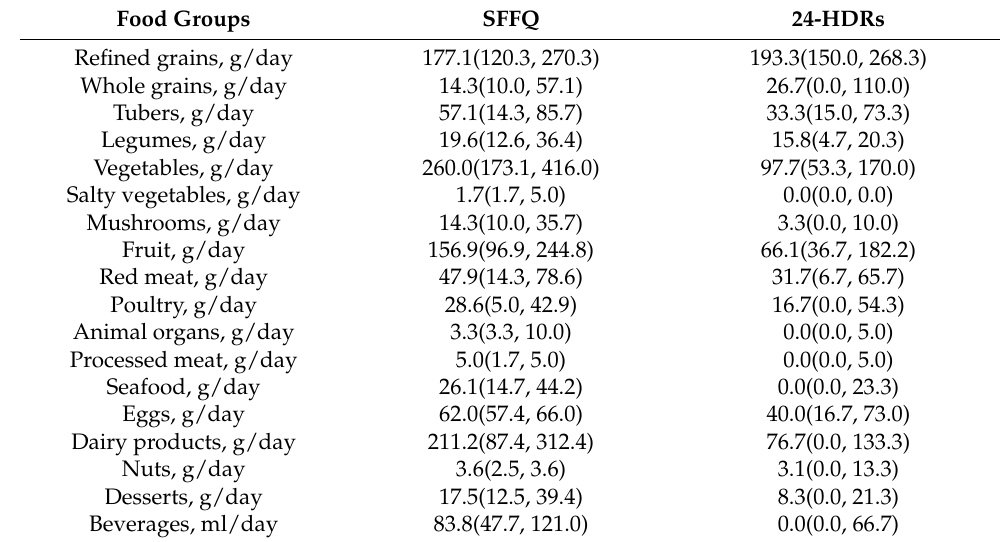
Table 1. Median (interquartile ranges) food group intakes estimated by the SFFQ and the 24-HDRs.